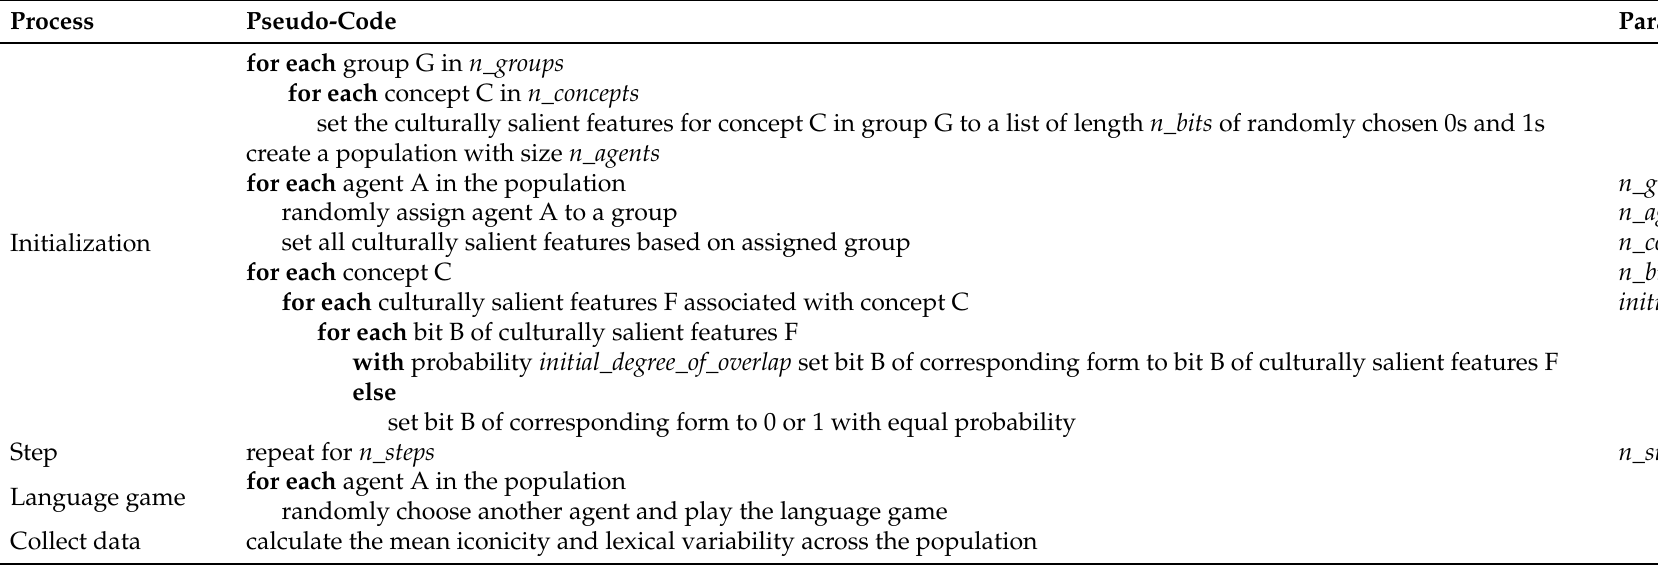
Table 1. Processes, scheduling, pseudo-code and